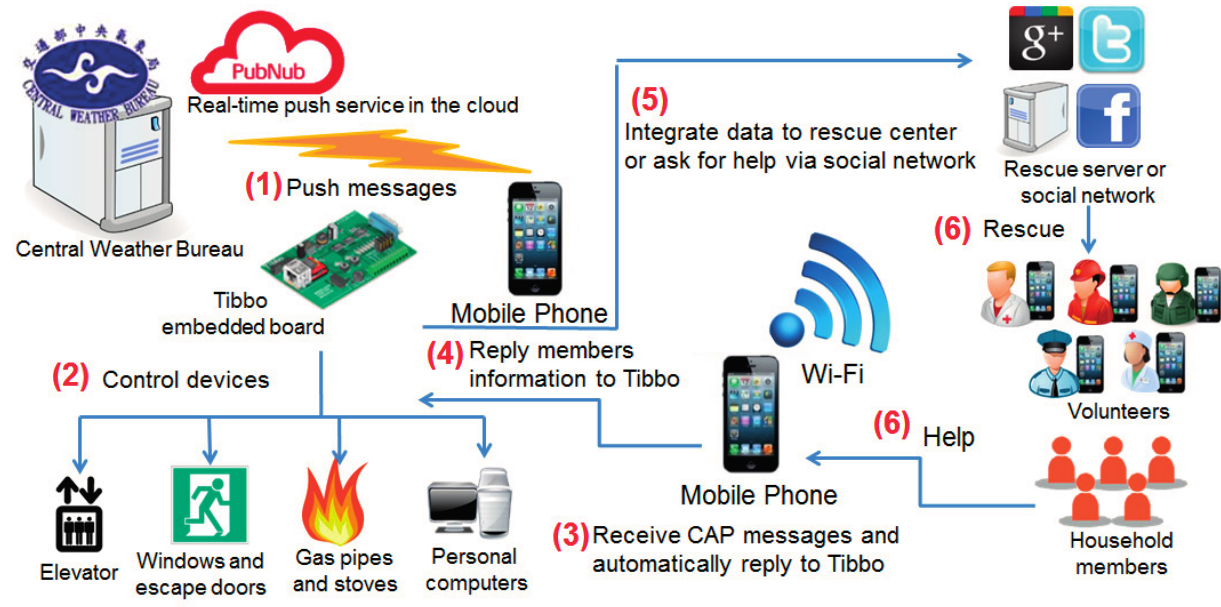
Figure 1. Active disaster response system flow